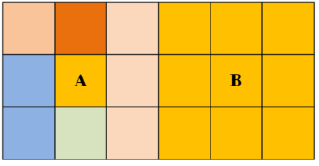
Figure 1. Two pixels A and B in the image (the same color represents the same classification posterior probability): pixel A is in a heterogeneous area and pixel B is in a homogeneous area.